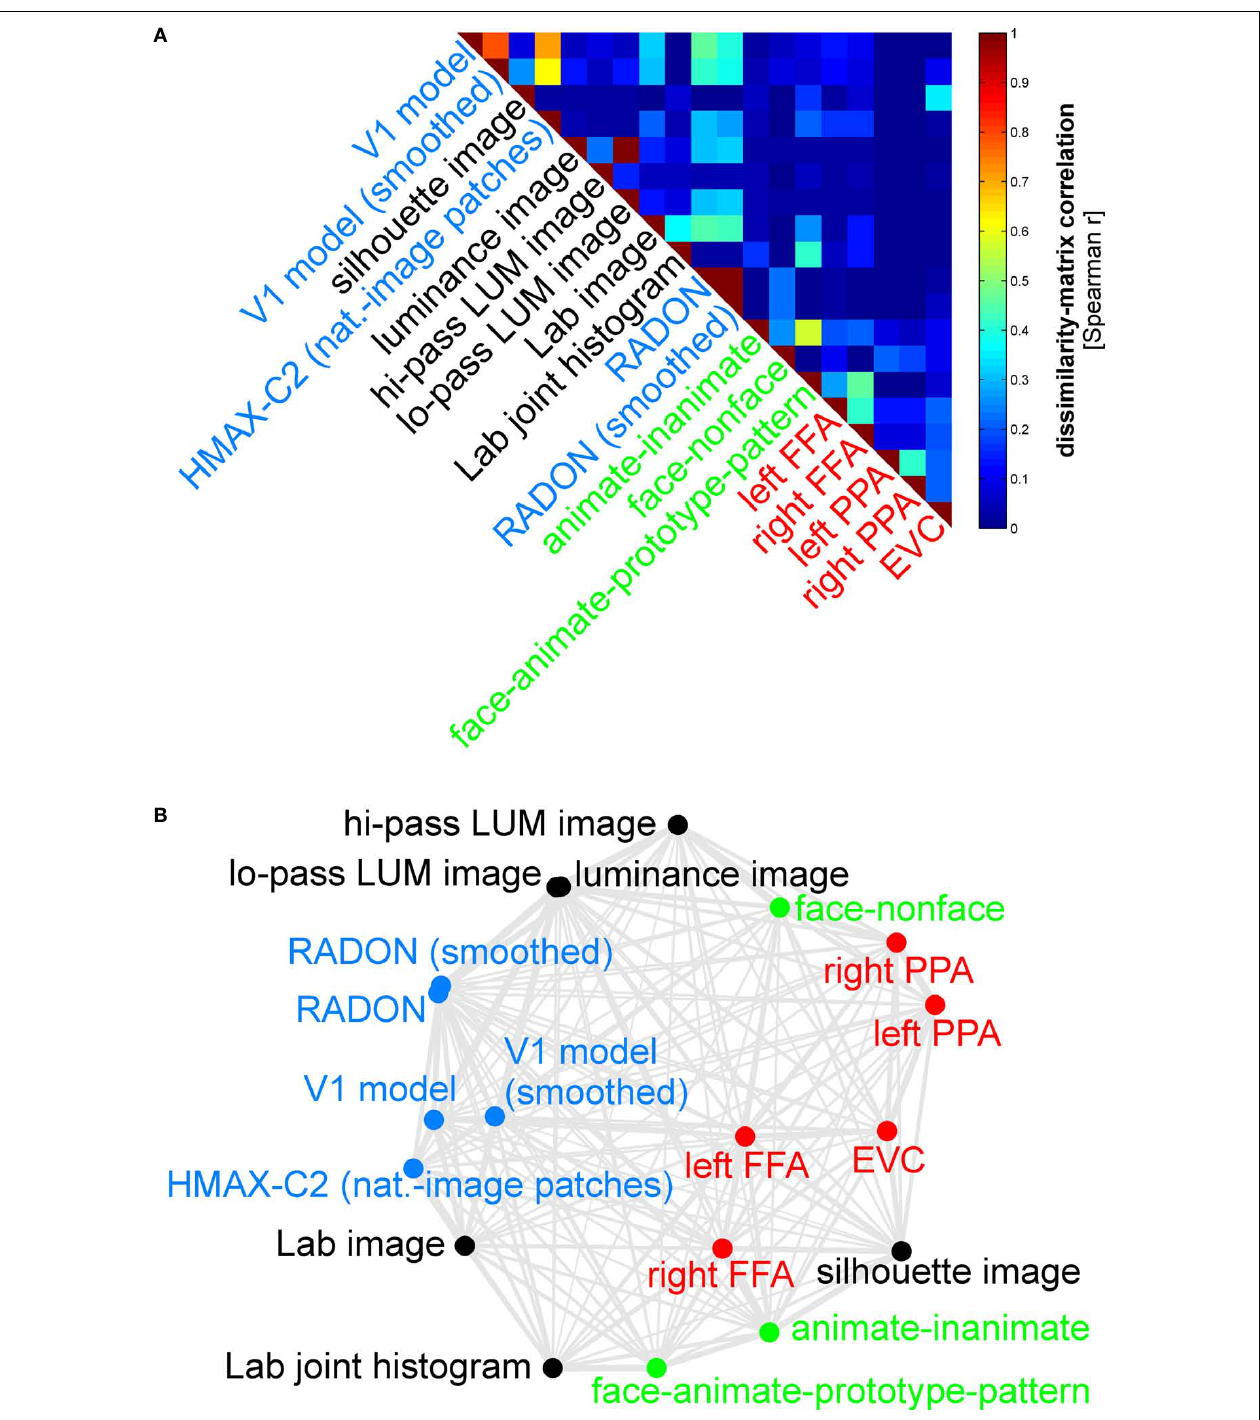
FIGURE 9 | Simultaneously relating all pairs of representations . Figure 8 showed the relationships between two reference regions and all models and other regions. Here we simultaneously visualize the pair-relationships between all models and regions (text labels). Note that the visualization of all pair-relationships comes at a cost: statistical information is omitted here. Text- label colors indicate the type of representation: complex computational model (blue), simple computational model (black), conceptual model (green),